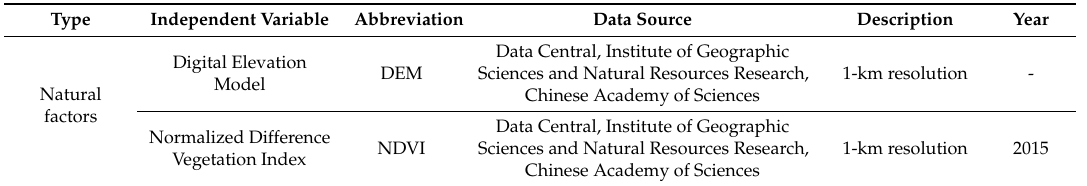
Table 1. Summary of potential impact